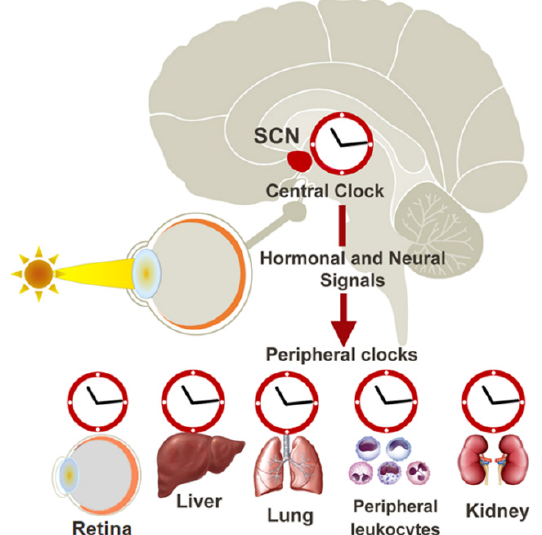
Figure 1. The mammalian circadian clock network. The mammalian circadian clock network consists of the central clock located in the suprachiasmatic nucleus (SCN) of the hypothalamus and peripheral oscillators present in virtually all cell types. Light activates a specific group of photoreceptors in the retina that are connected to the central SCN clock, which synchronises and entrains peripheral circadian clocks via neural and endocrine pathways.